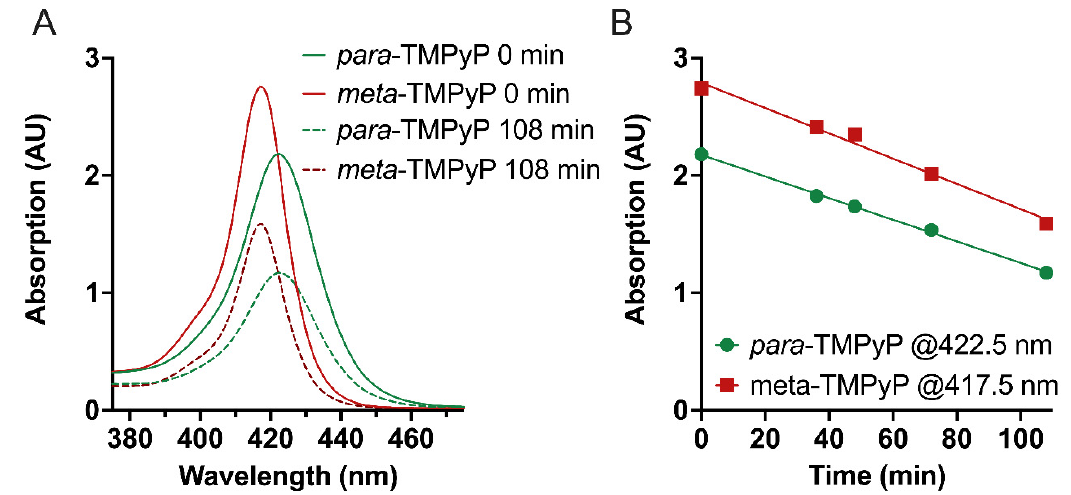
Figure 3. Photostability of meta -TMPyP and para -TMPyP as determined by measurements of absorption after illumination at 420 nm LED light with an intensity of 13 mW/cm 2 for indicated durations (0.78 J/cm 2 per minute). ( A ) UV–VIS absorption spectra in the range of their most intense absorption band (B band) before and after 108 min of illumination. Please note the hypsochromic shift of the absorption maximum by 4 nm as well as the stronger absorption of the meta-TMPyP variant when compared to para -TMPyP (see Table 1). ( B ) Change in absorption at the respective wavelengths and indicated time points during illumination. An approximately linear decay of absorption was observed for both TMPyP variants.